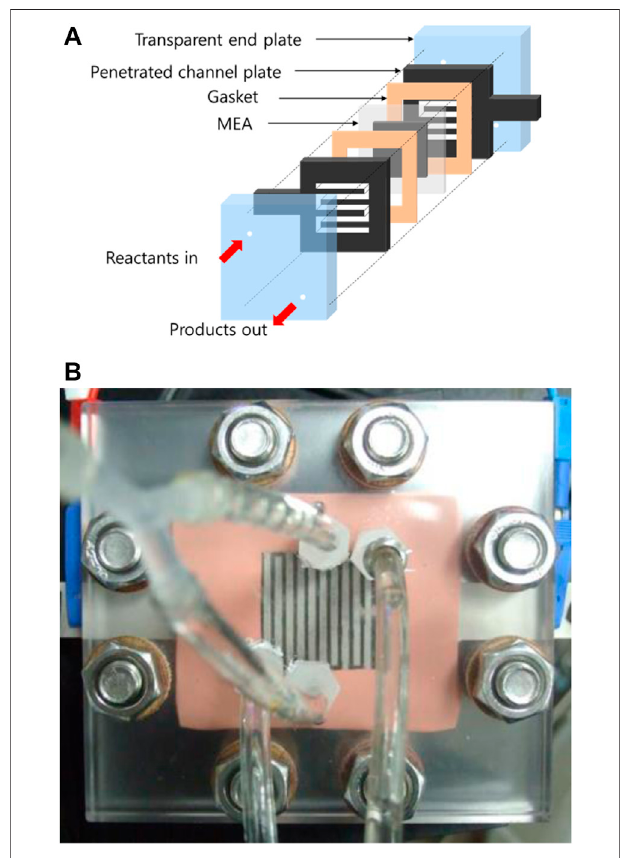
FIGURE 1 | (A) Schematic and (B) picture of a membrane electrode assembly with a proton exchange membrane in a transparent cell fi xture.